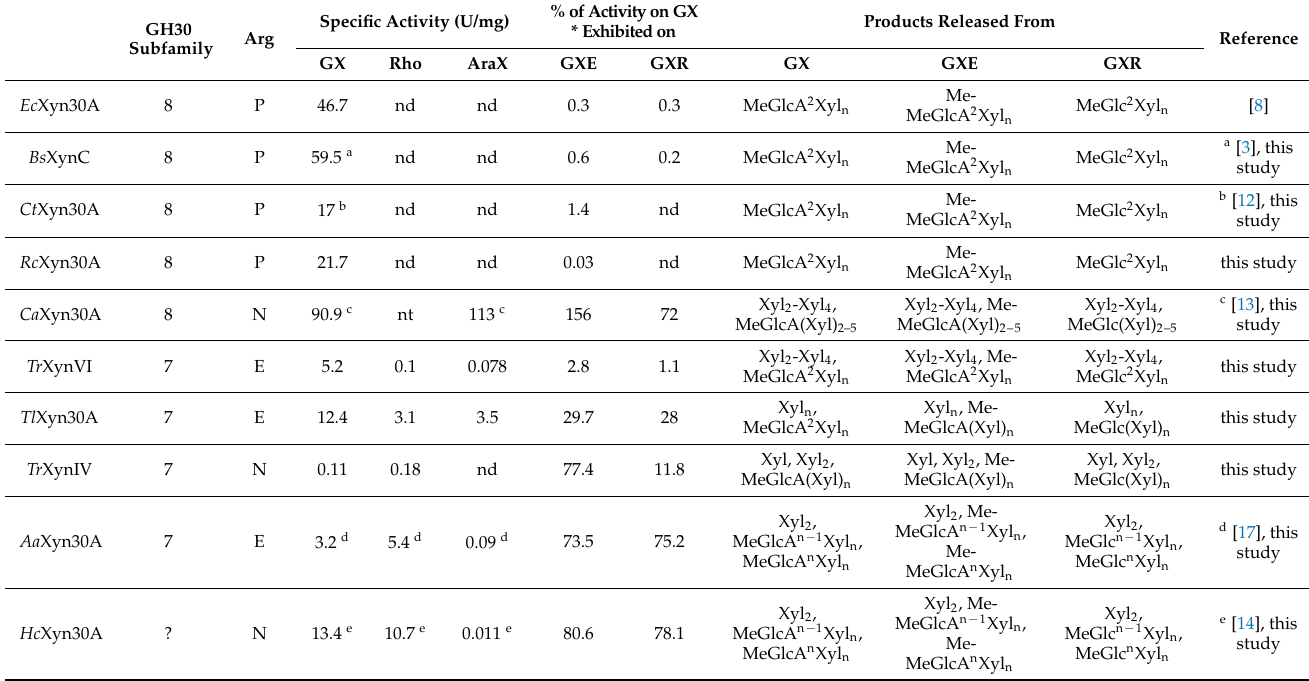
Table 1. Performance of GH30 xylanases on Rho, AraX and GX and its uncharged modifications GXE and GXR. Abbrevia- tions: P, presence of prokaryotic Arg; E, presence of eukaryotic Arg and N, absence of both Args. Specific Activity (U/mg) %ofActivityonGX *Exhibitedon Products Released From GH30 Arg Subfamily